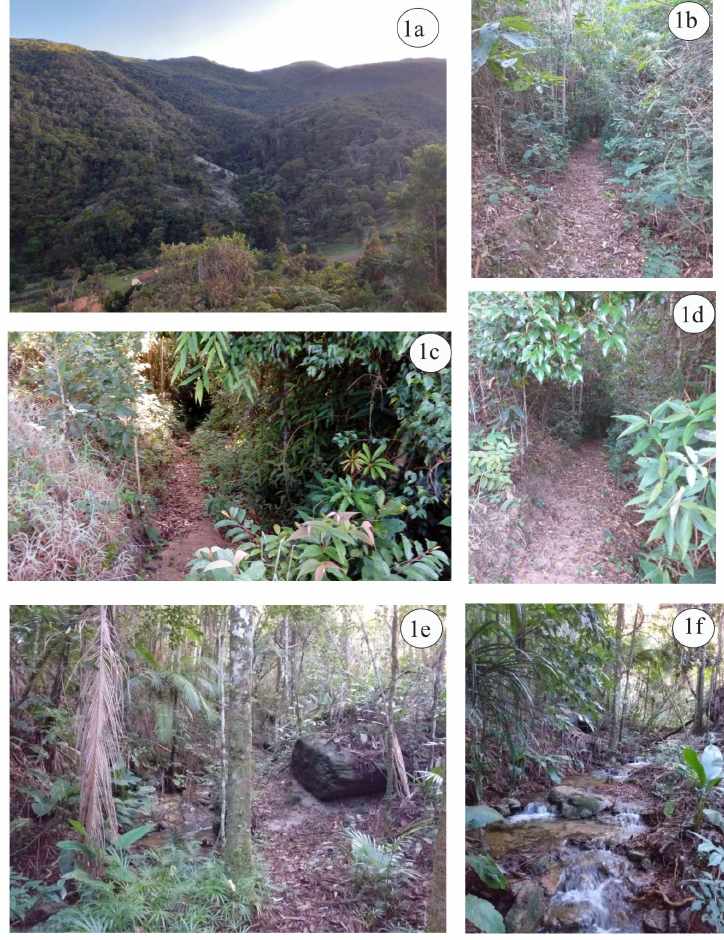
Figure 1. a-f. Serra Negra do Funil Natural Heritage Private Reserve (MG,